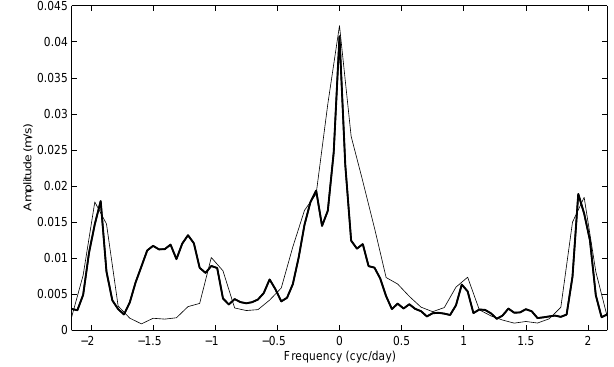
Fig. 2. Summer (bold) and winter (light) rotary spectra for current- meter at station B11, deployed at a 22m